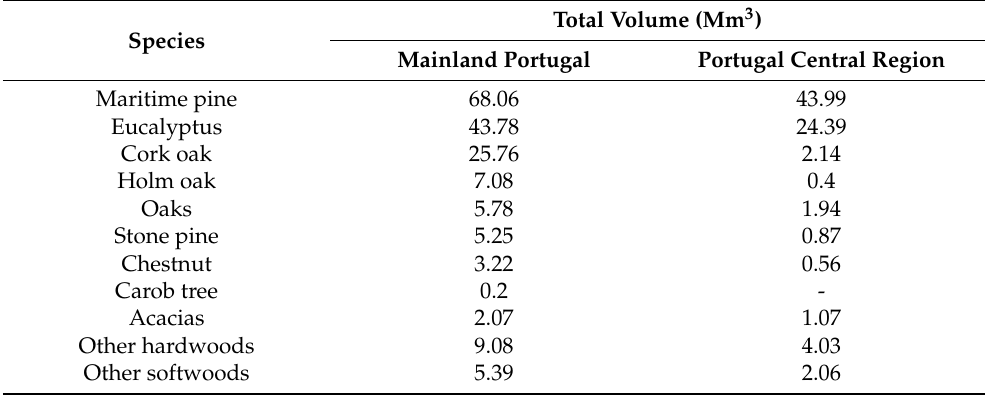
Table 3. Total existing volume by species, in mainland Portugal, in 2015 (adapted from http://www. icnf.pt, accessed on 18 December